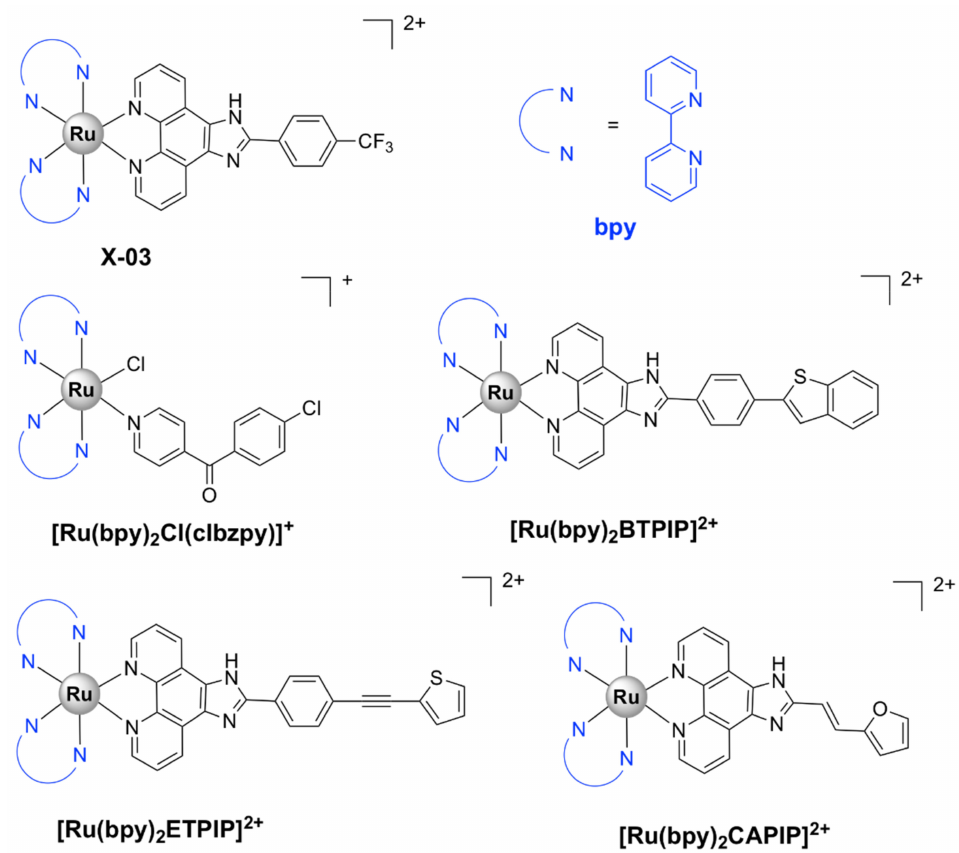
Figure 4. Chemical structures of heteroleptic Ru(II) complexes bearing 2,2’-bipyridine (bpy) ligands. BTPIP = (2-(4-(benzo[b]thiophen-2-yl)phenyl)-1 H -imidazo [4,5- f ][1,10]phenanthroline); ETPIP = 2-(4-(thiophen-2-ylethynyl)phenyl)-1 H -imidazo[4,5- f ][1,10]phenanthroline); CAPIP = (E) -2-(2-(furan- 2-yl)vinyl)-1 H -imidazo[4,5- f ][1,10]phenanthroline; dmp = 4,4’-dimethyl-2,2’-bipyridine; bpy = 2,2’- bipyridine; phen =